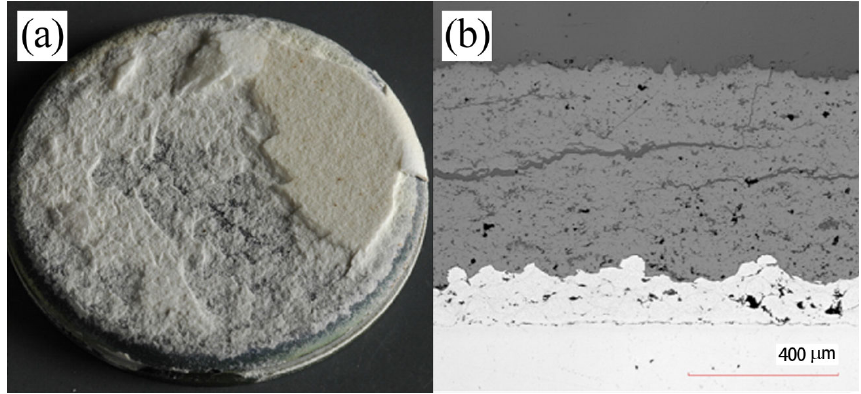
Fig. 52 (a) Macroscopic optical image and (b) cross-sectional SEM image of an APS TBC cycled to failure in thermal gradient conditions (~1250 ℃ at the TBC surface and ~1080 ℃ at the bond coat) on a burner rig with simultaneous CMAS injection. Reproduced with permission from Ref. [266], © Elsevier B.V.